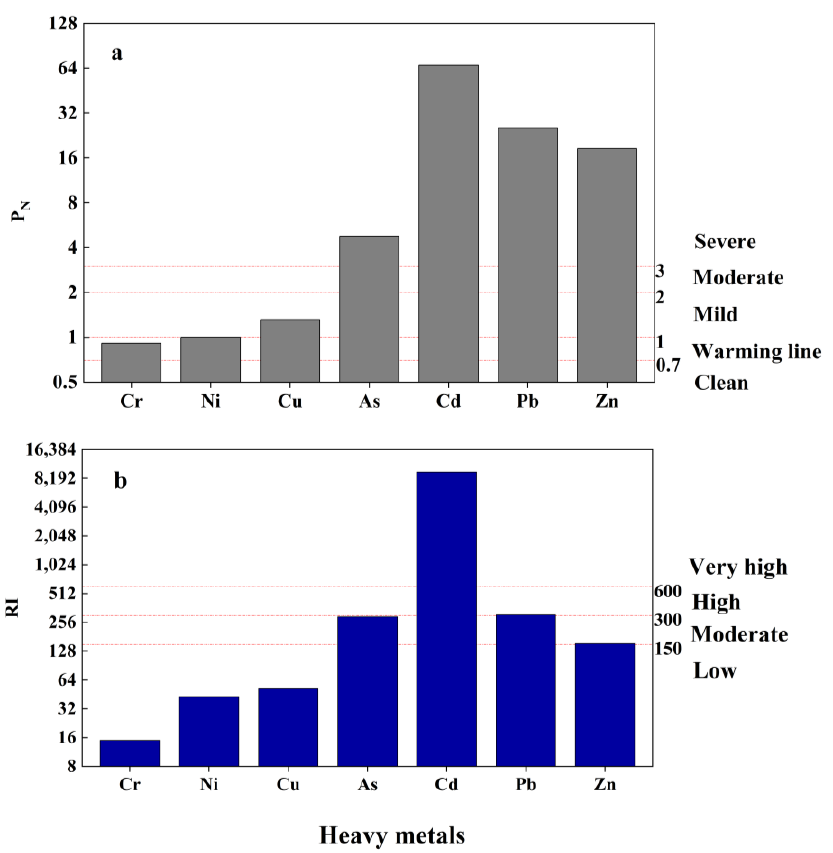
Figure 6. Nemeiro comprehensive pollution assessment and potential ecological risk assessment of soils. ( a ) P N of heavy metals; and ( b ) RI of heavy